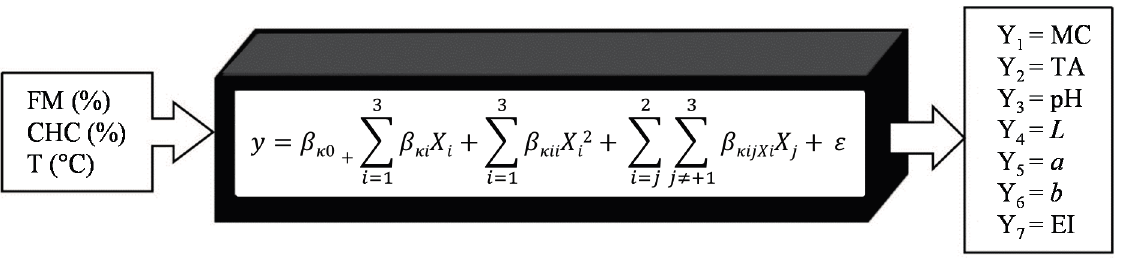
Figure 10. Empirical model of the interaction between processing and response